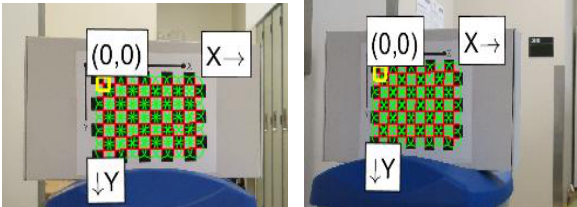
Figure 8. The images-driven 3D point cloud of the target